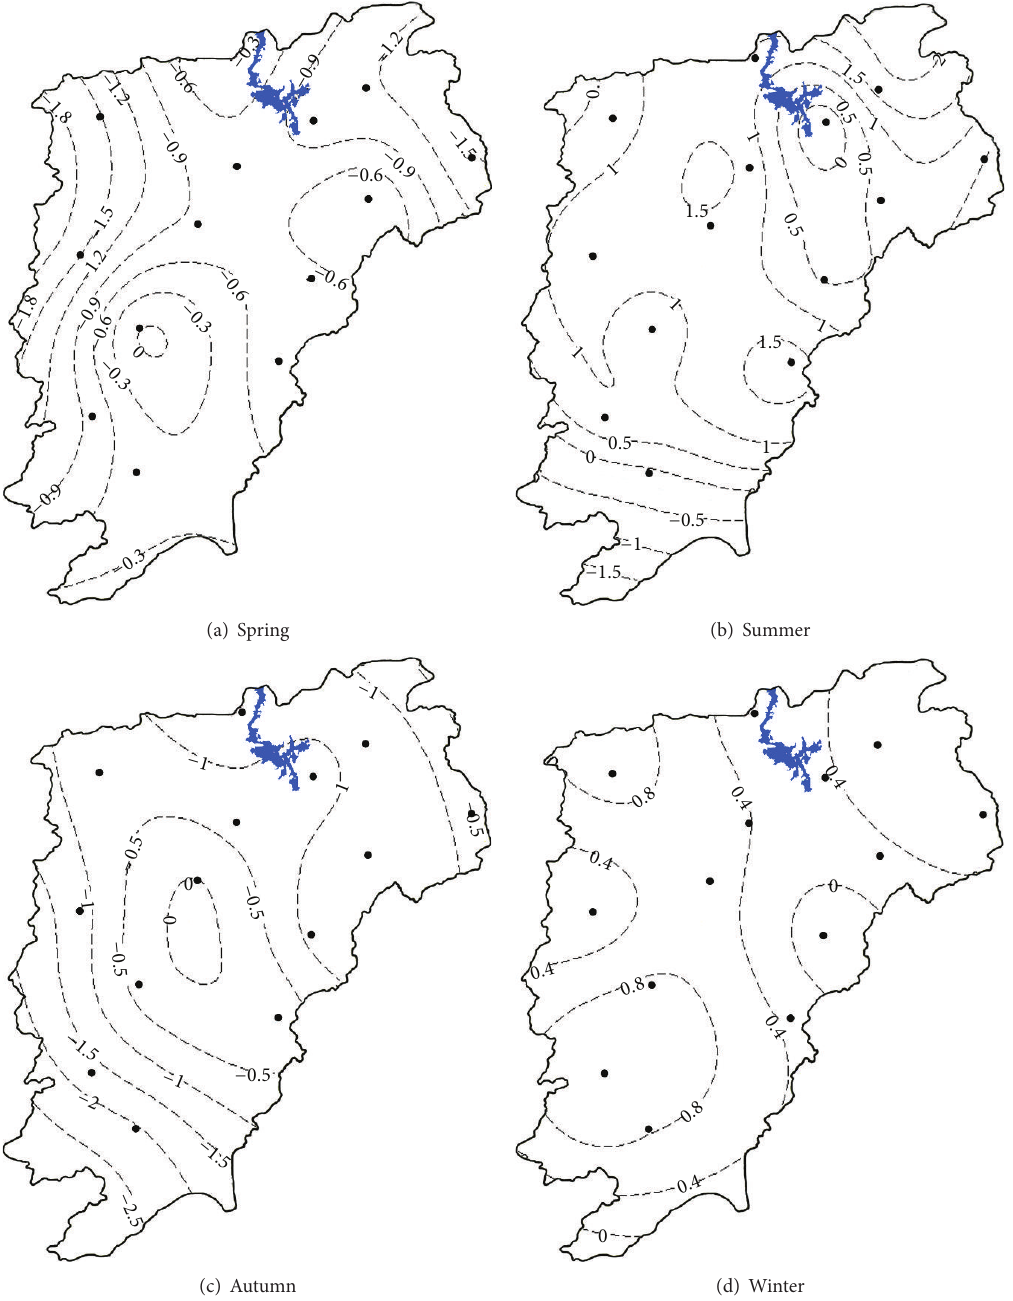
Figure 4: Spatial distribution pattern of trends of SPEI in (a) spring (March, April, and May), (b) summer (June, July, and August), (c) autumn (September, October, and November), and (d) winter (January, February, and December) across the Poyang Lake basin. The numbers in the figure are 𝑍 values of MK test. Positive values indicate increasing trend and vice versa. If |𝑍| ⩾ 1.96 , then the trend is significant at > 95% confidence